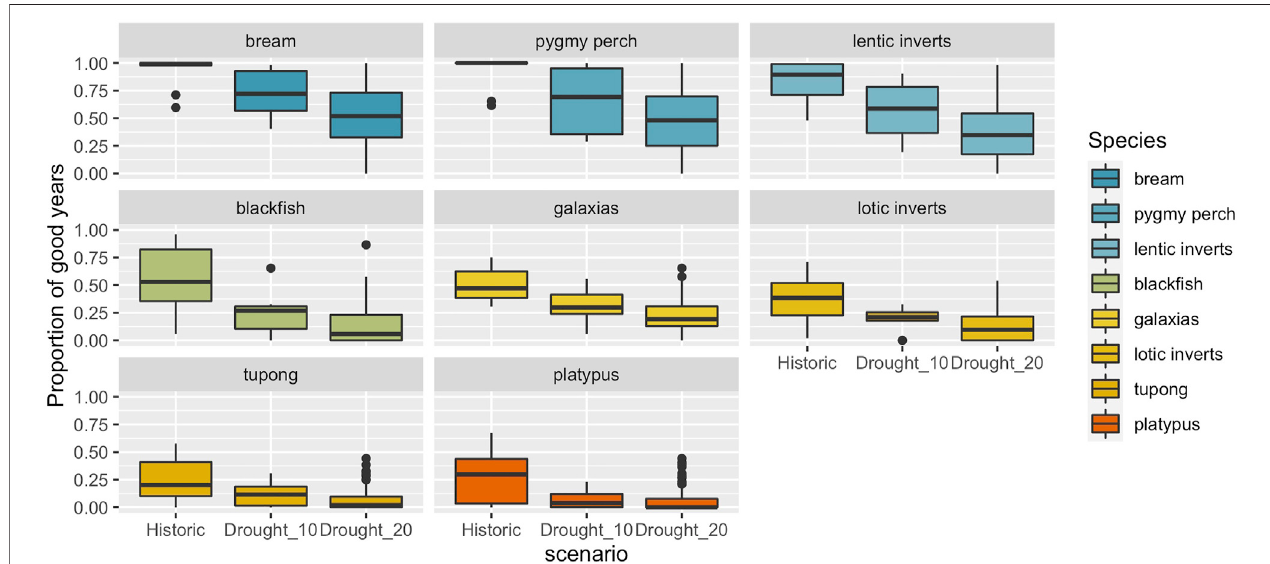
FIGURE 6 | Summary of condition of each population/community under replicate ( n = 100) stochastic projections of hydrologic sequences for each climate scenario: historical, 10% drought increase,and 20% drought increase.Boxes represent the 25 – 75thpercentiles, whiskers represent 5 – 15th and 75th-95th percentiles, and individual points the 5th and 95th